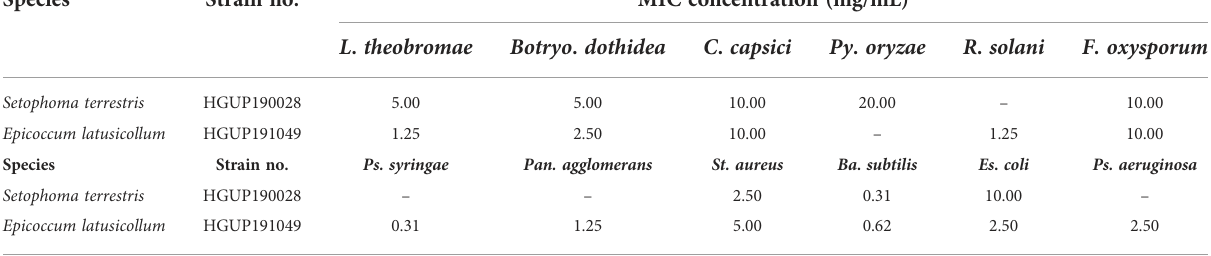
TABLE 1 The minimum inhibitory concentration (MIC) of extracellular metabolites of two endophytic isolates against 12 tested strains. Species Strain no.